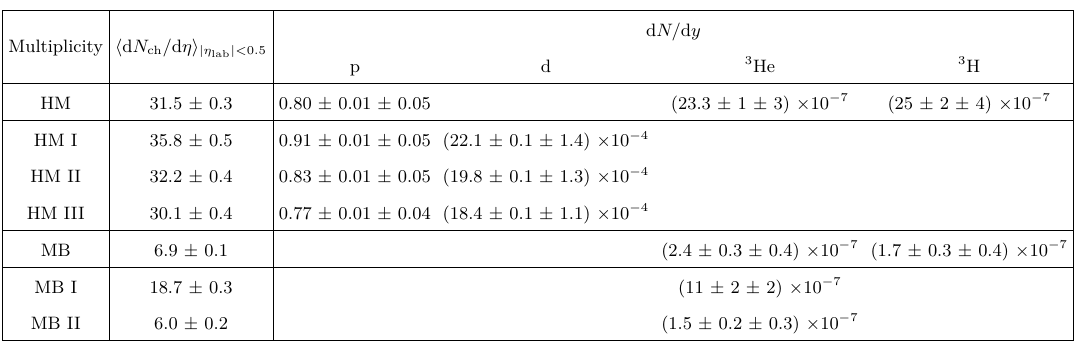
Table 2. Multiplicity classes for the different measurements, with the corresponding multiplicity h d N ch / d η i , and p T -integrated yields d N/ d y for the different species (average for particle and | η lab | < 0 . 5 antiparticle). For h d N ch / d η i , only the systematic uncertainty is reported, because the sta- | η lab | < 0 . 5 tistical one is negligible. For d N/ d y , the first uncertainty is statistical and the second is systematic.